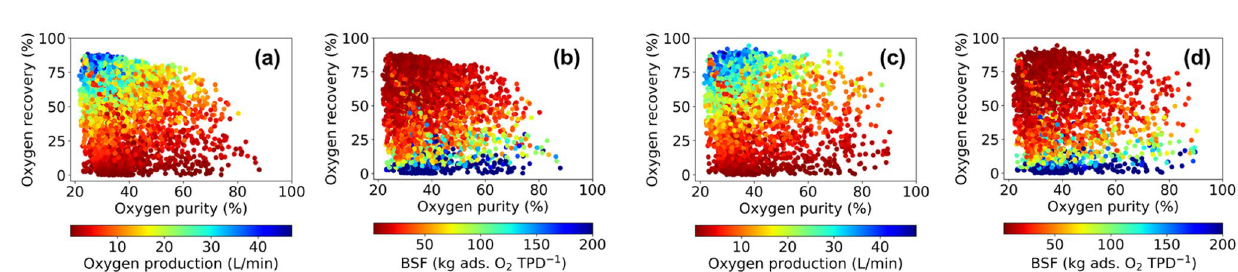
Figure 6. Process simulation data and output performance metrics for LiLSX zeolite. ( a , b ) PSA cycle and ( c , d ) PVSA cycle.